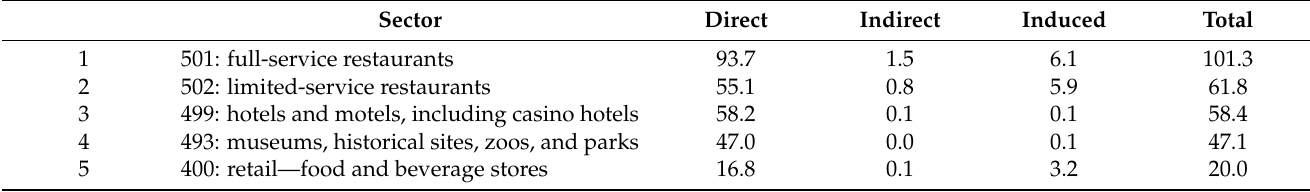
Table A7. Top Five Affected Sectors by Employment.